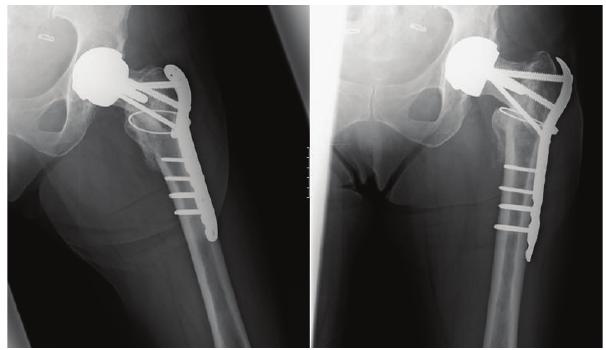
Figure 8: AP views, 8 months from surgery.